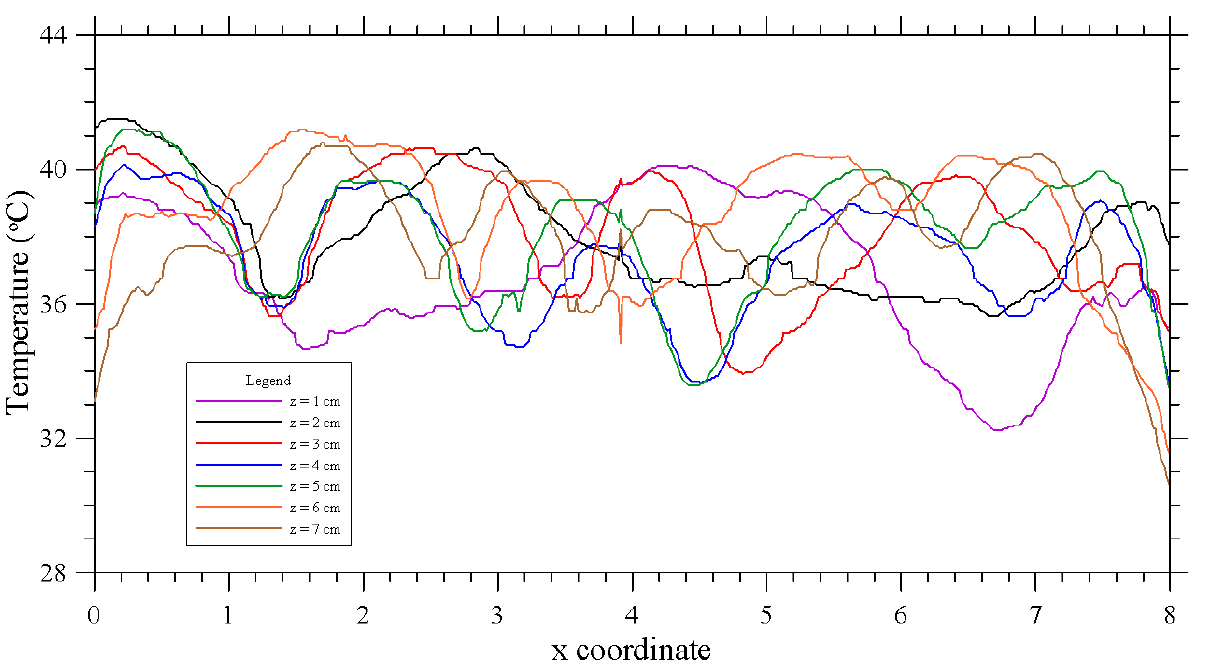
Figure 12. Profiles of temperature at different stations along the longitudinal direction z (square container, A = 10.6, d = 0.75 cm, Bo dyn ≅ 1.94, ∆ T = 27 °C, ϑ ≅ 5°).